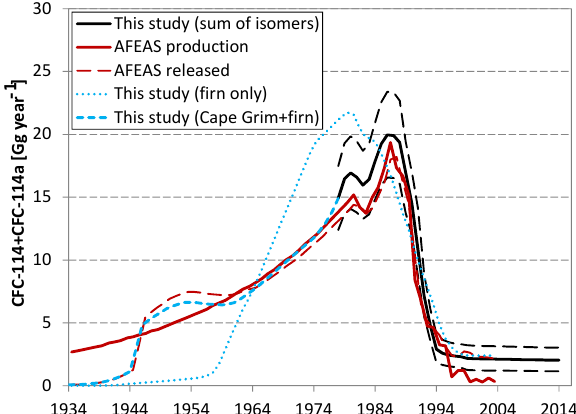
Figure 3. Global emissions of CFC-114 and CFC-114a derived from Cape Grim observations (solid lines) with uncertainties repre- sented by dashed lines. The dotted lines represent emissions derived purely from firn air data.